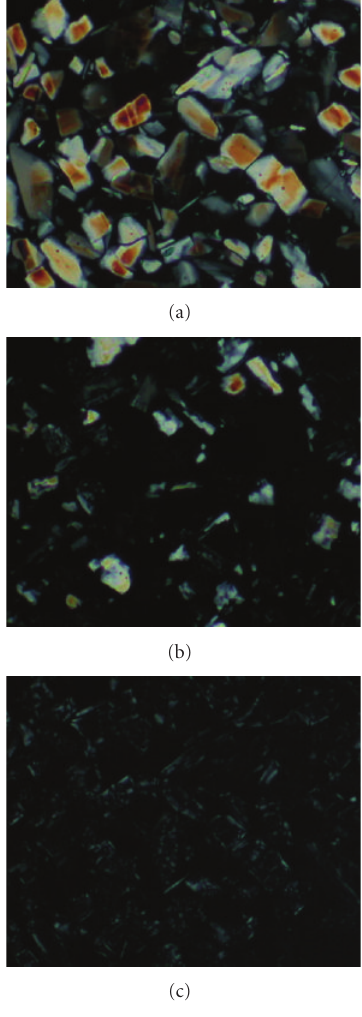
Figure 15: Polarized optical micrographs of cholesteryl nonanoate dispersed in UV15 taken during heating from the solid phase at (a) 25 ◦ C, (b) 65.1 ◦ C, and (c) 75.7 ◦